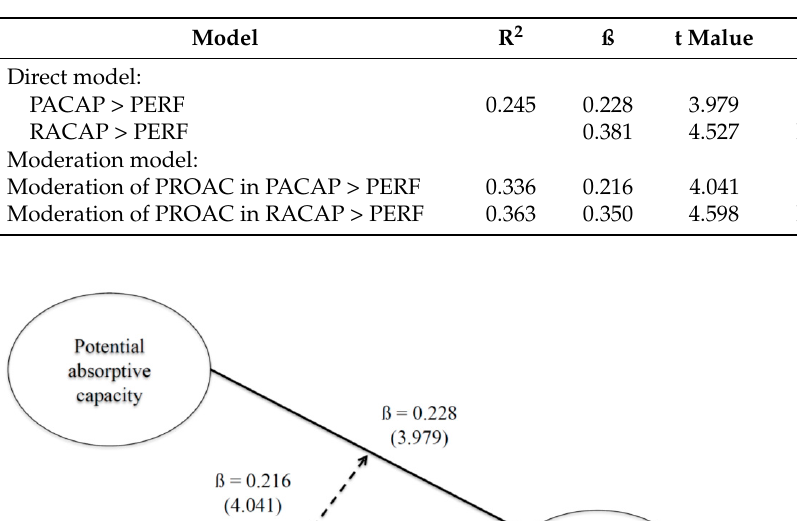
Table 6. Structural model.